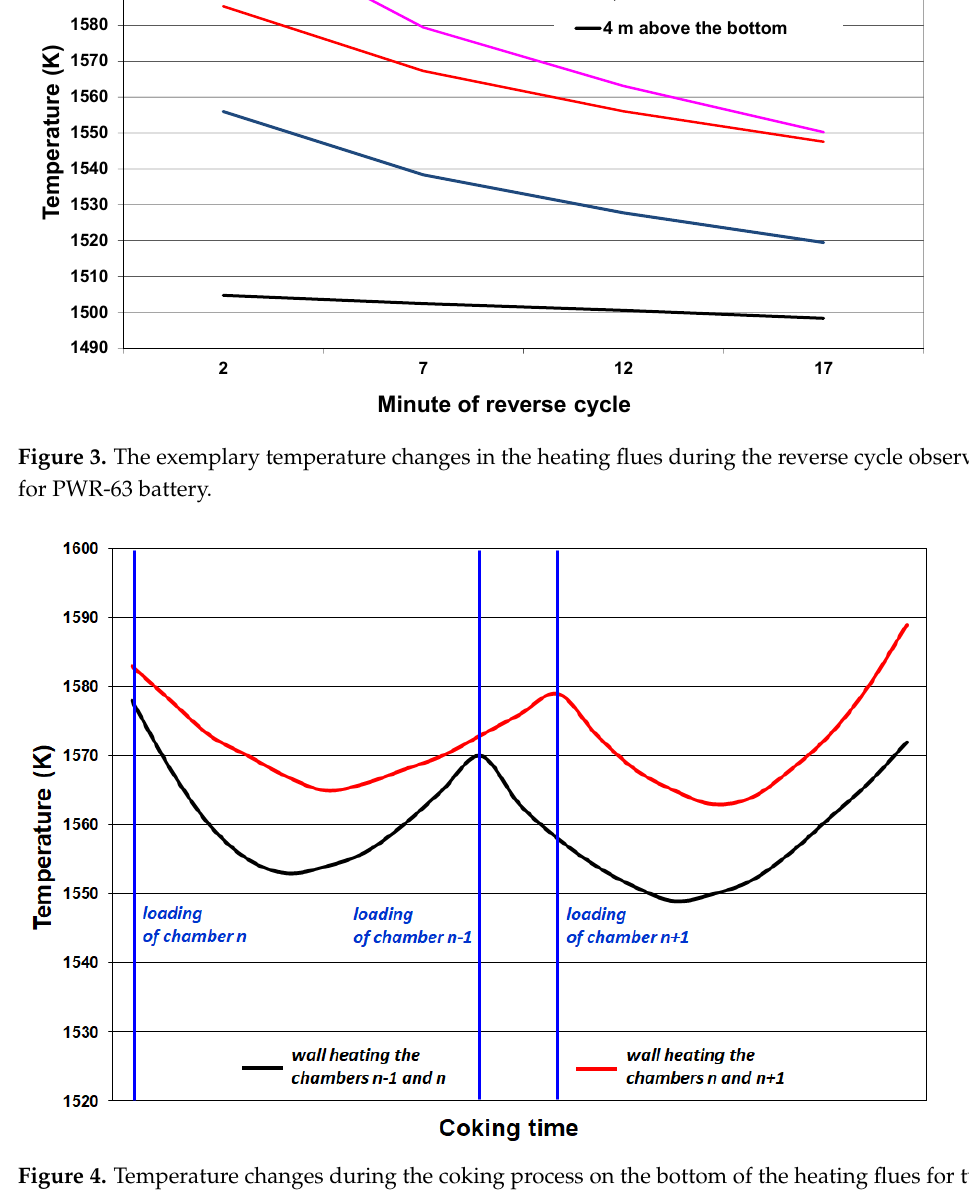
Figure 4. Temperature changes during the coking process on the bottom of the heating flues for two adjacent heating walls measured at one of the Polish coke oven battery [2].